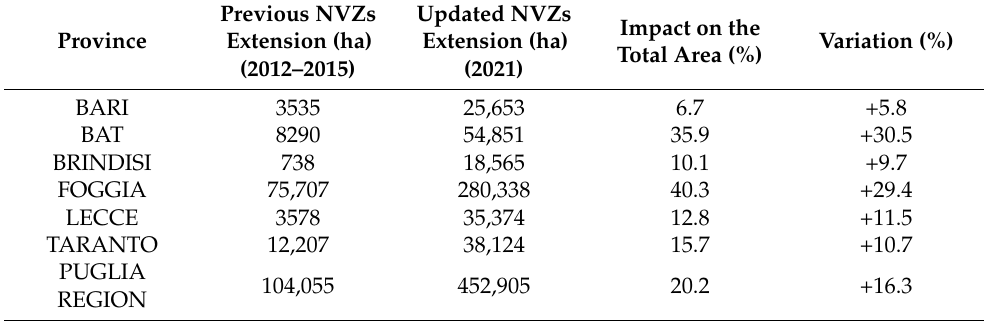
Table 7. Summary tables of the new perimeter of Nitrates Vulnerable Zones year 2019.